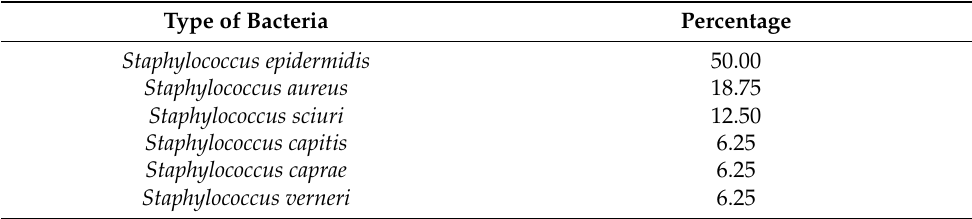
Table 9. Type and percentage of Staphylococcus